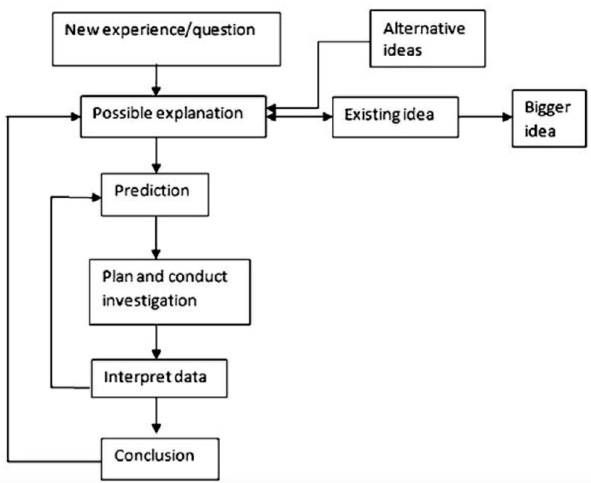
Figure 2. A route diagram aiming at understanding the inquiry process, as proposed in the framework of the Fibonacci Project ([26], p. 5).